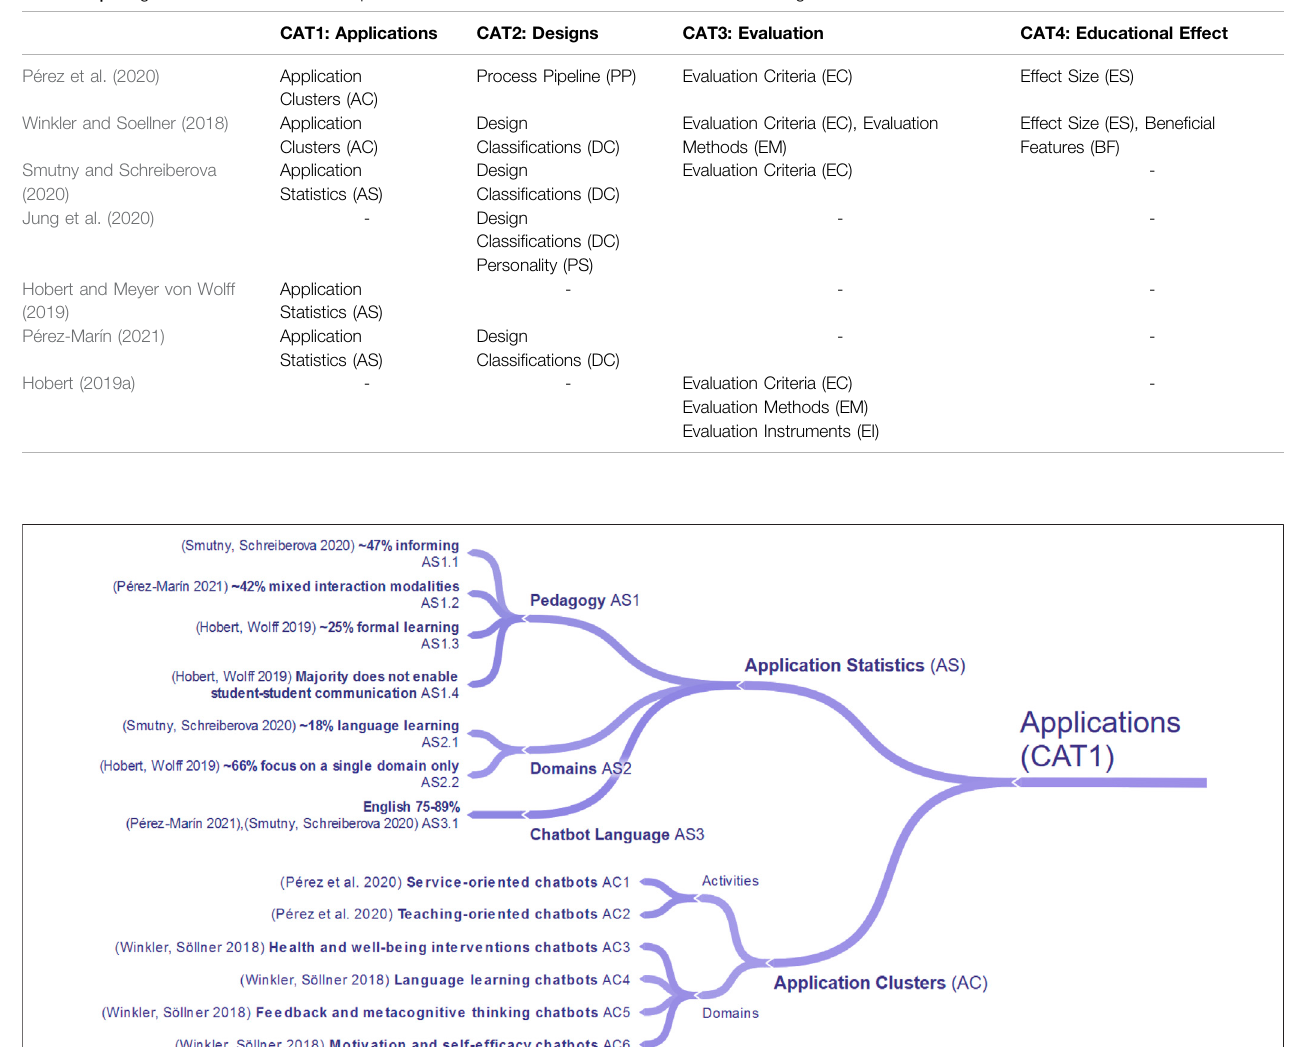
TABLE 1 | Assignment of coded research topics identi fi ed in related literature reviews to research categories.